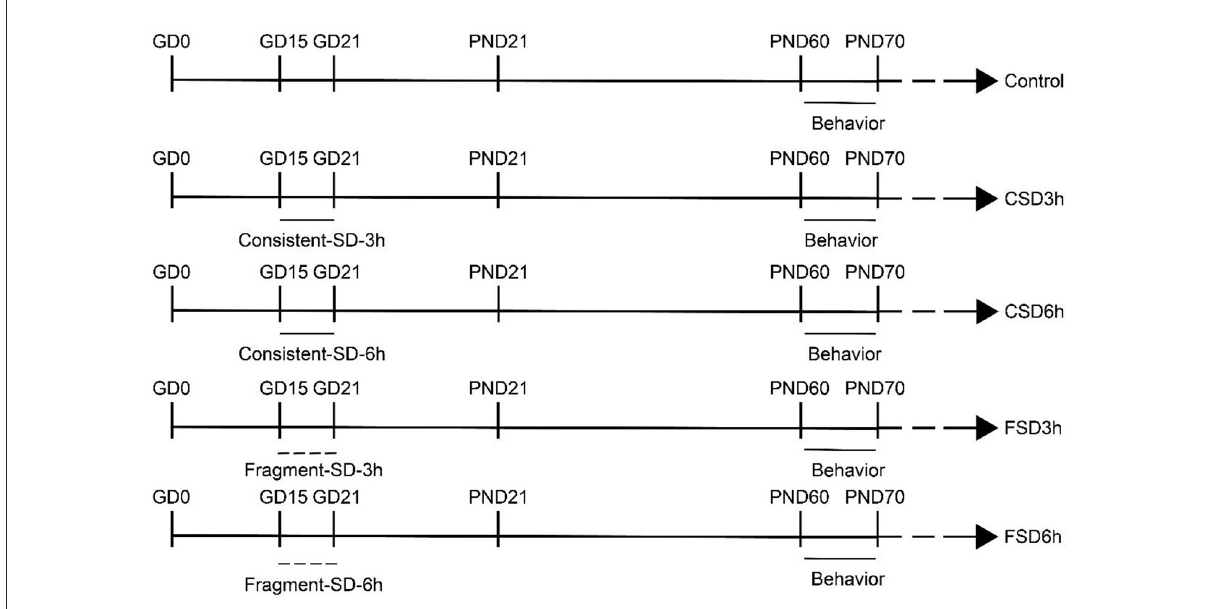
FIGURE1 Timeline of the experiment (refer to experimental protocols for